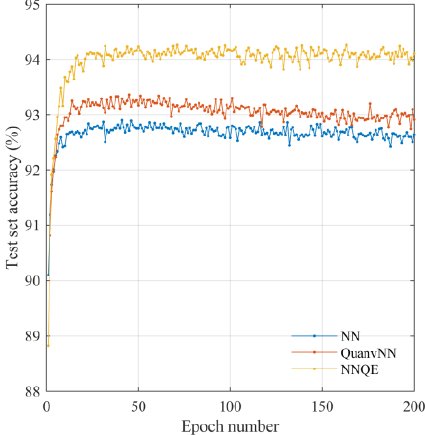
Figure 8. Test set accuracy against MNIST dataset images.